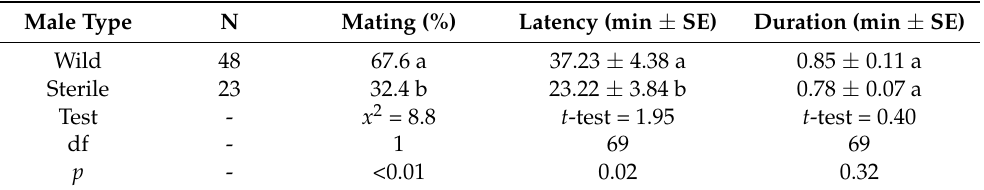
Table 7. Mating competitiveness of sterile and wild Aedes albopictus . In total 98 replicates were